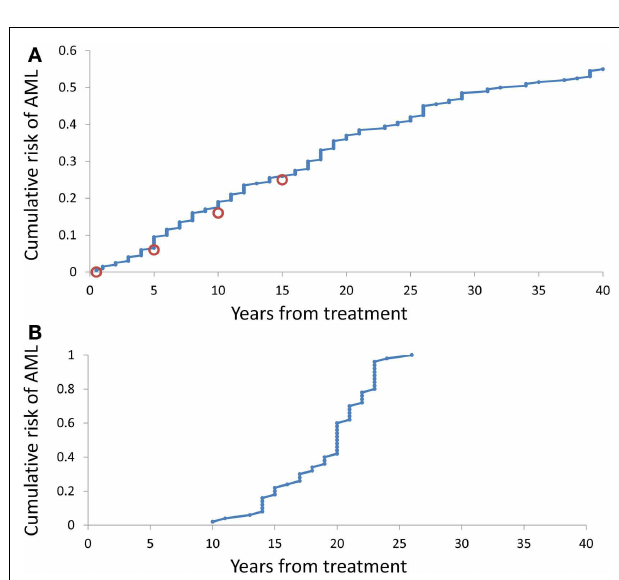
FIGURE 4 | Cumulative distributions of the model-generated times at diagnosis of sAML. (A) Simulations under model as in Eq. 7 with A generated using Eq. 8, ε = 0.2, and k = 2. (B) Simulations under model as in Eq. 8 with A = 0.02, ε = 0.2, and k = 2.